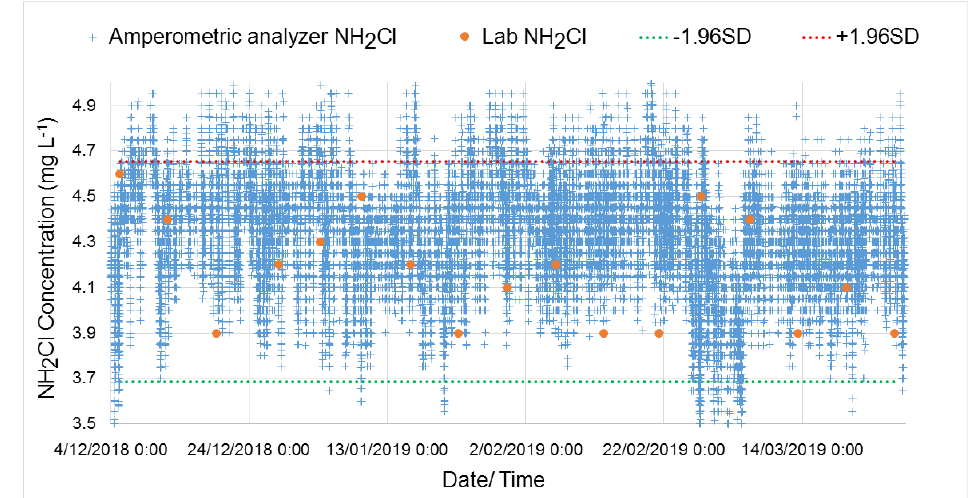
Figure A1. Comparison of online monochloramine analyser data with lab data (green and red dotted line indicate 95% confidence interval for lower and upper limit).